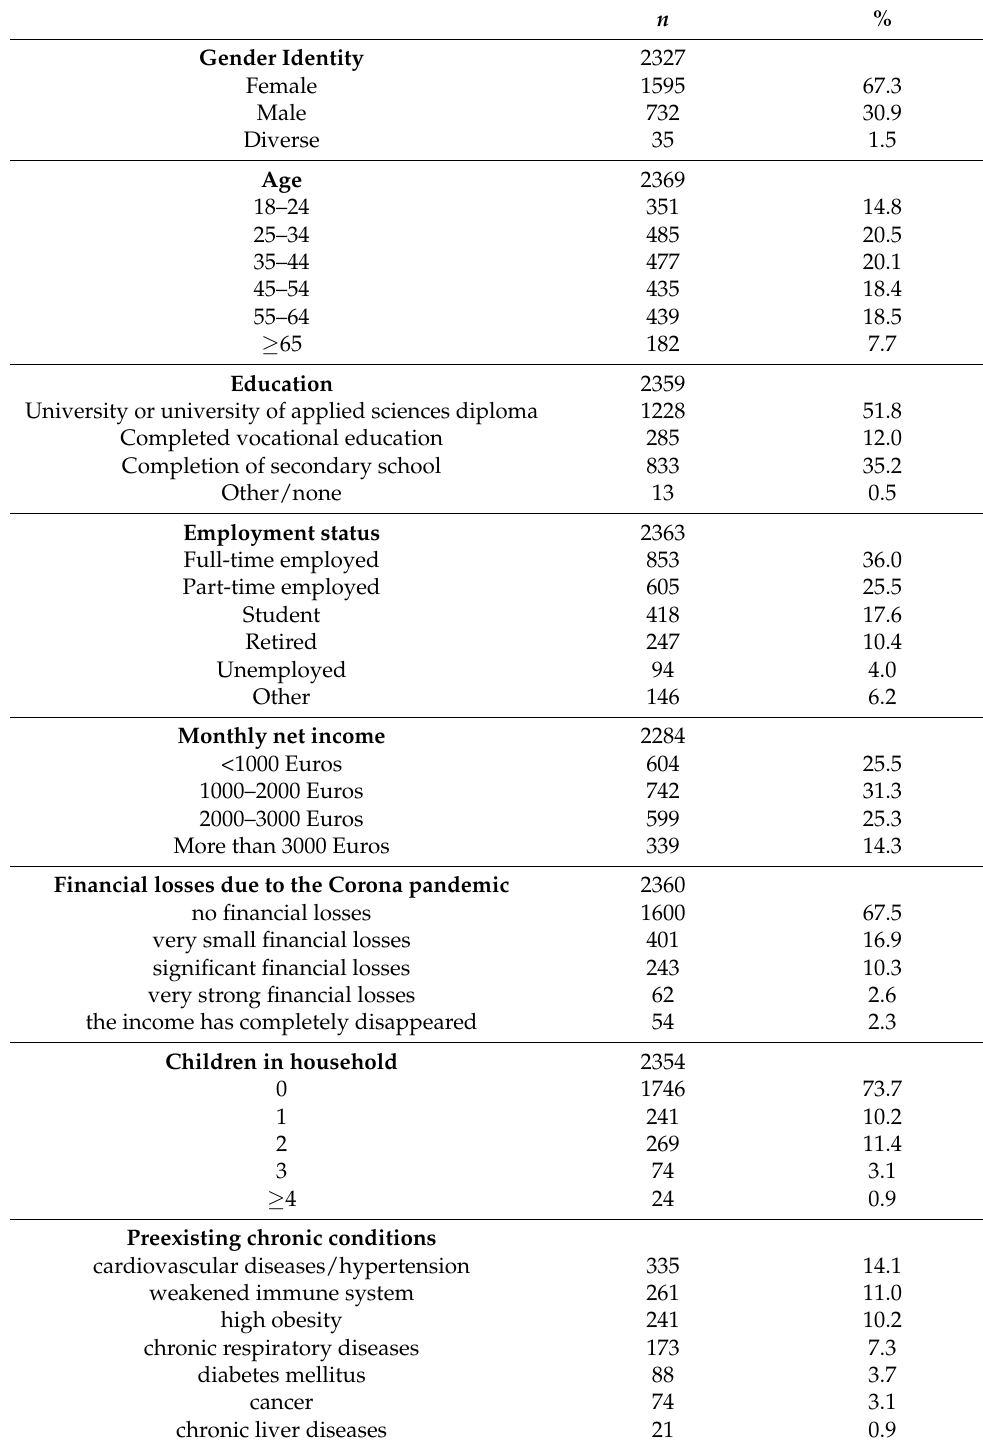
Table 1. Sociodemographic data of the entire